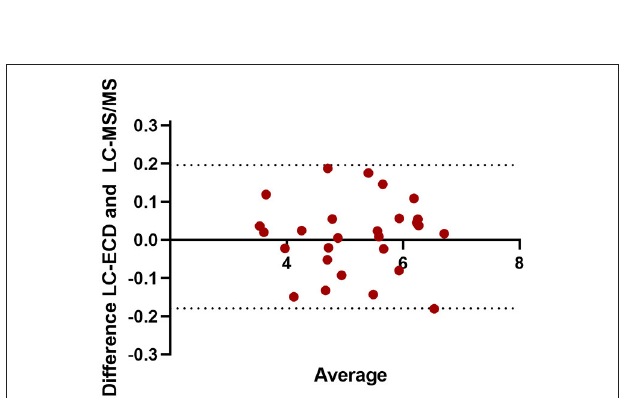
FIGURE 2 | Bland-Altman plot of glucosamine concentrations in hydrolyzed commercial chitin and chitin extracts of different insect exuviae measured by LC-ECD and LC-MS/MS ( N = 27). The x-axis shows the mean of the results, and the y-axis shows the absolute glucosamine difference in mg/L between LC-ECD and LC-MS/MS measurement. The mean bias was − 0.01 ± 0.09, and the 95% limits of agreement were − 0.17 to 0.19.